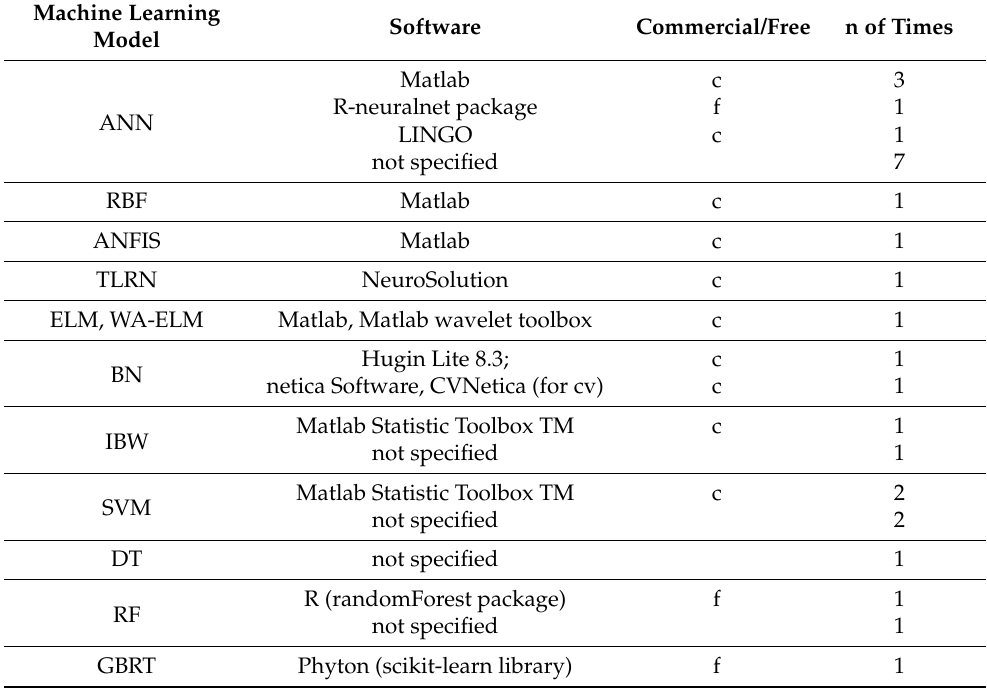
Table 2. Software used for the machine learning models in the reviewed